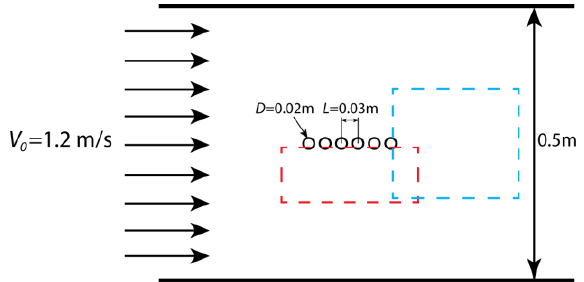
Fig. 2. Measured areas at test section